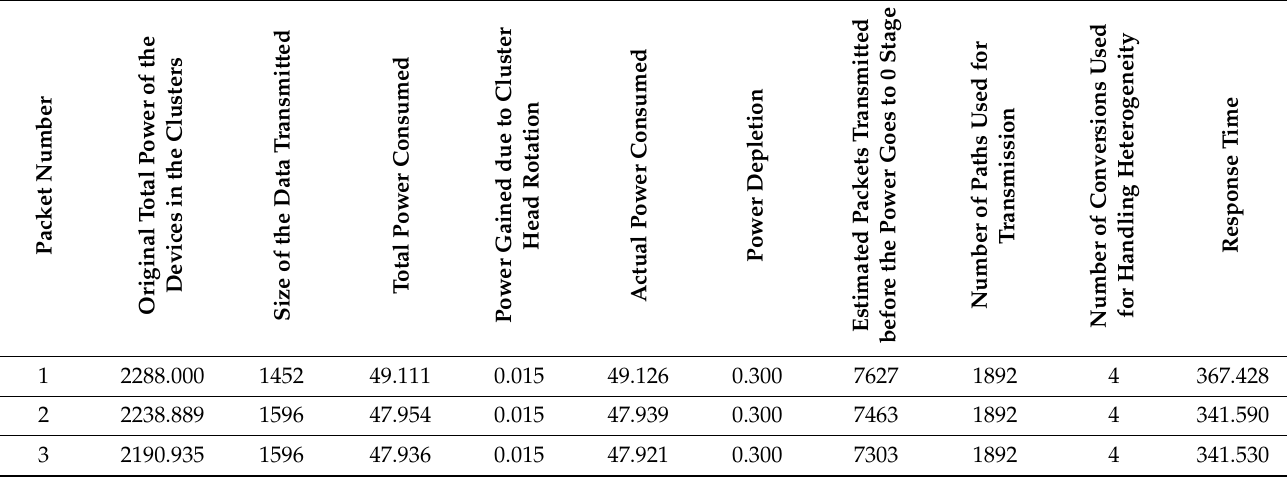
Figure 11. Revised IoT with parallel computing initiated in the controller layer. Table 2. Summary of performance of cluster devices + multi-controller